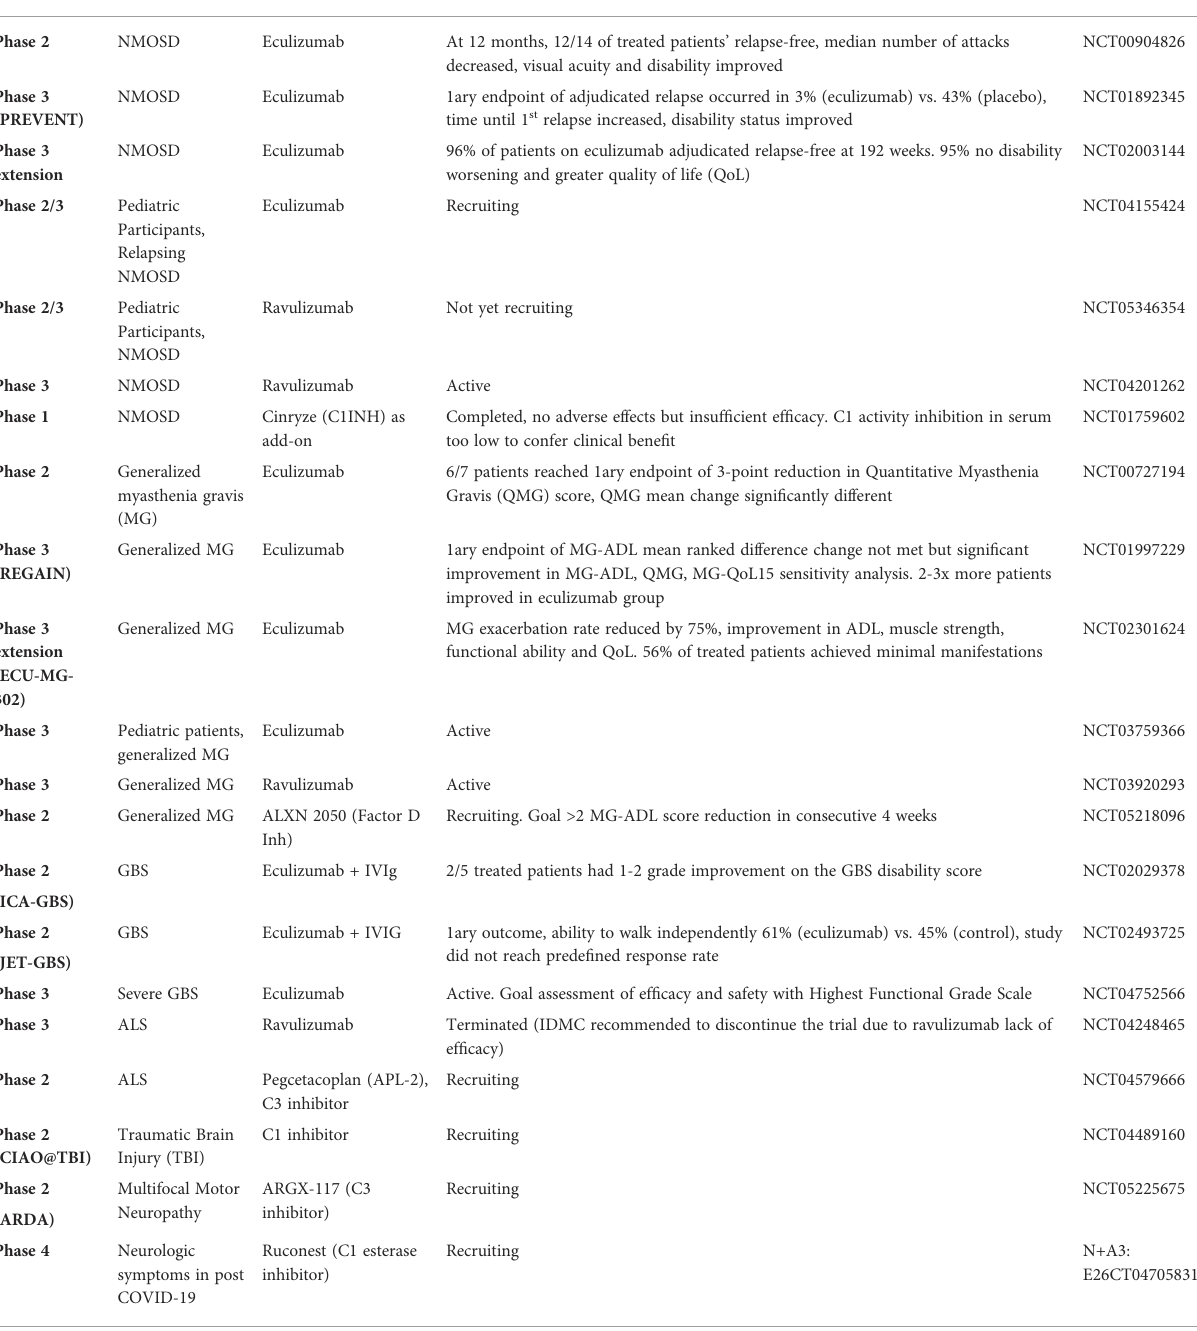
TABLE 2 Complement inhibitors in clinical trials for neurologic diseases. Complement inhibitors in clinical trials for neurologic diseases PHASE DISEASE INTERVENTION RESULT/STATUS